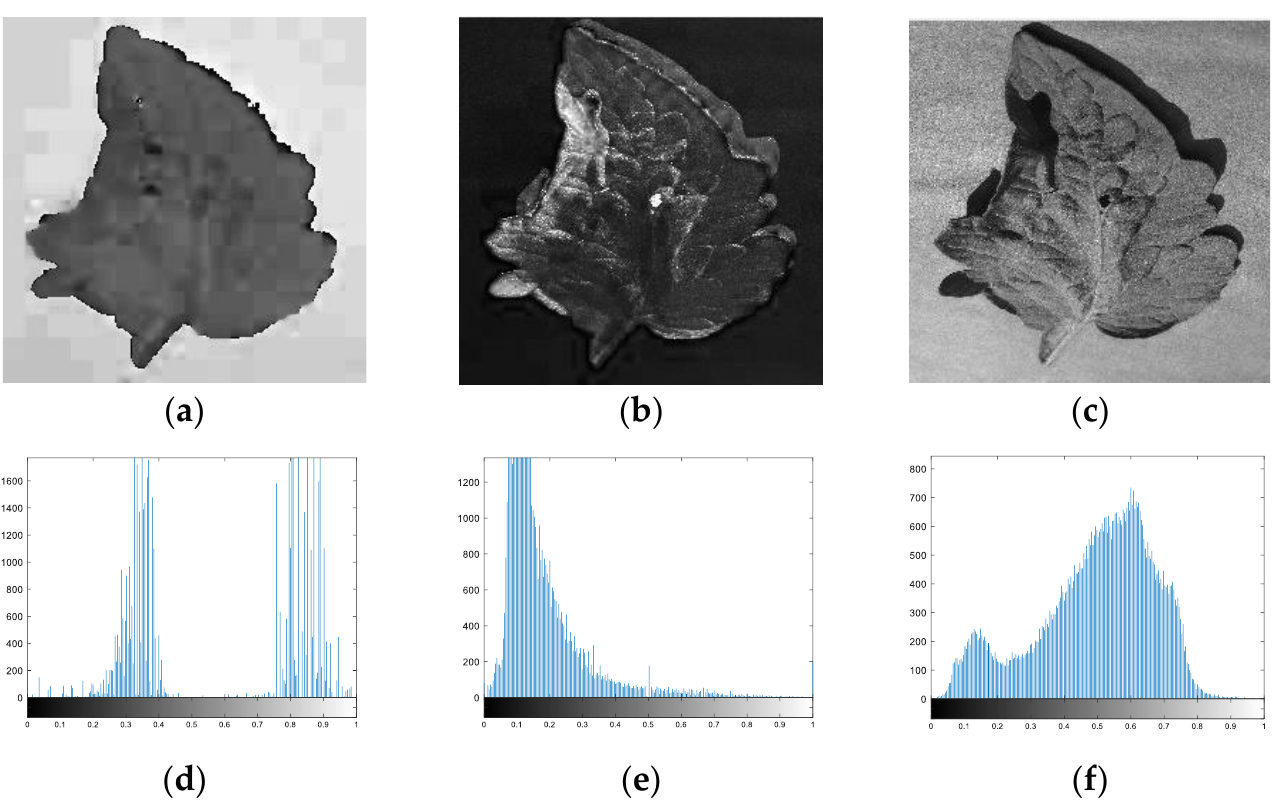
Figure 5. Input image in the HSV color space and the histograms of its components: ( a ) Hue component image; ( b ) Saturation component image; ( c ) Value component image; ( d ) Histogram of Hue component image; ( e ) Histogram of Saturation component image; ( f ) Histogram of Value component image.